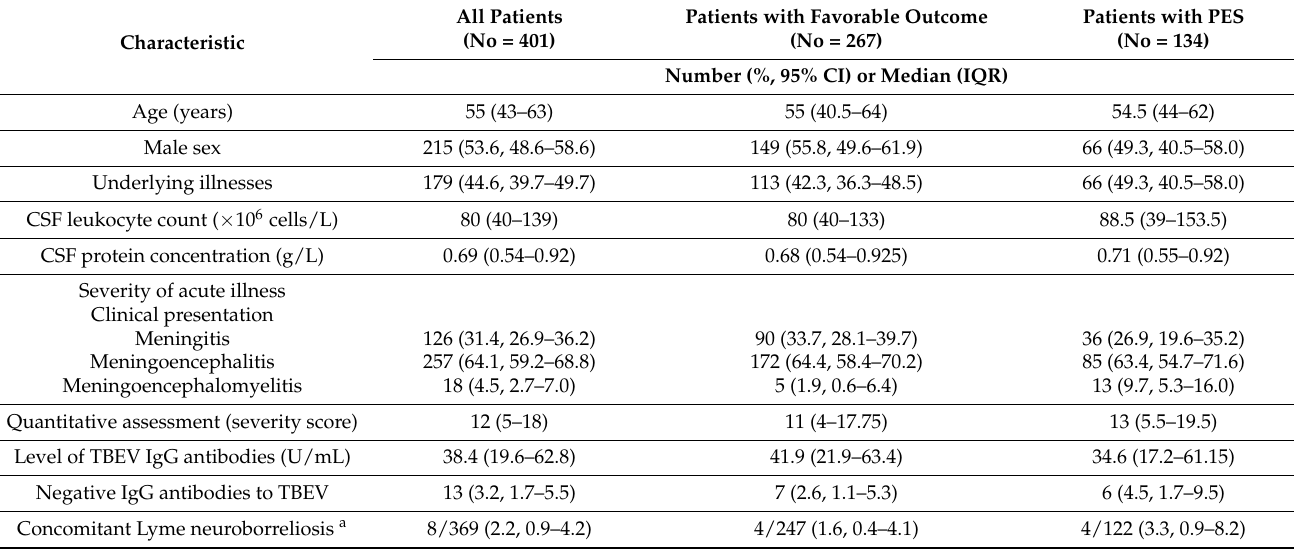
Table 3. Basic demographic, clinical, and laboratory data on 401 adult patients with tick-borne encephalitis according to the outcome of the disease 2–7 years